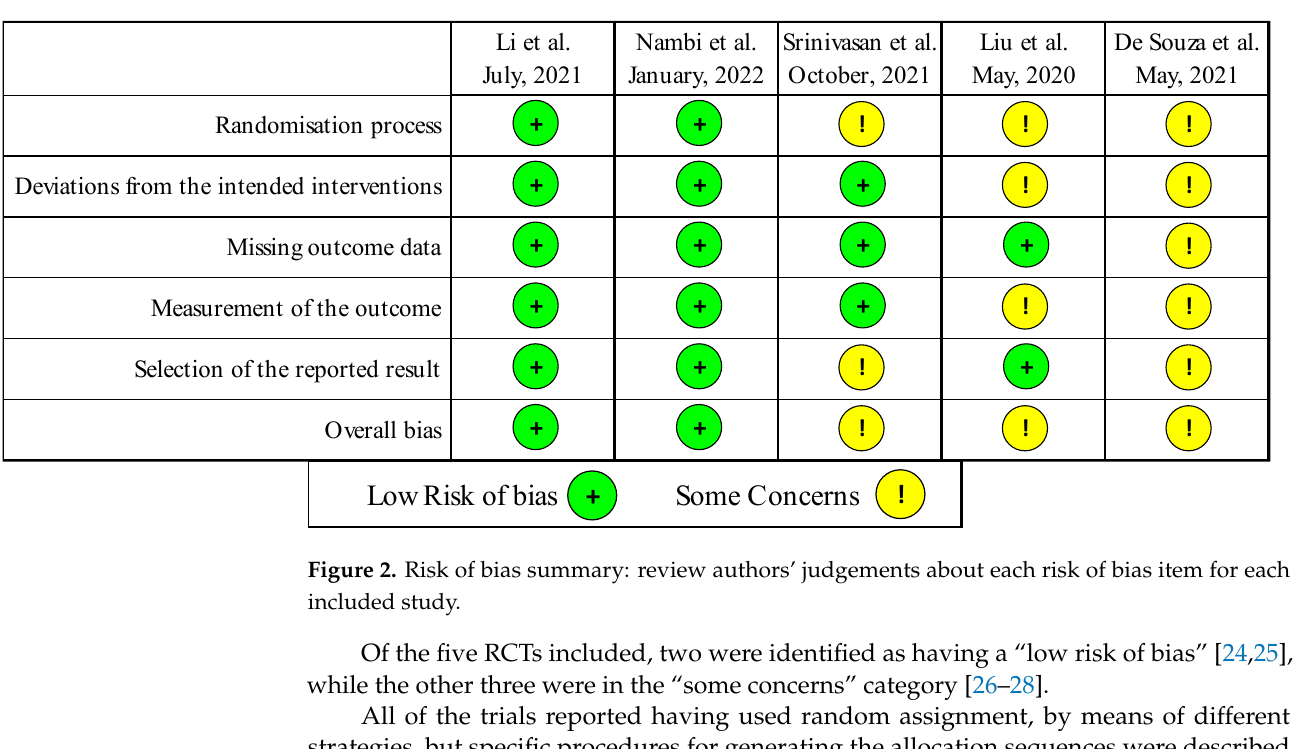
Table 1. Characteristics of included studies. Study Country N° of Participants